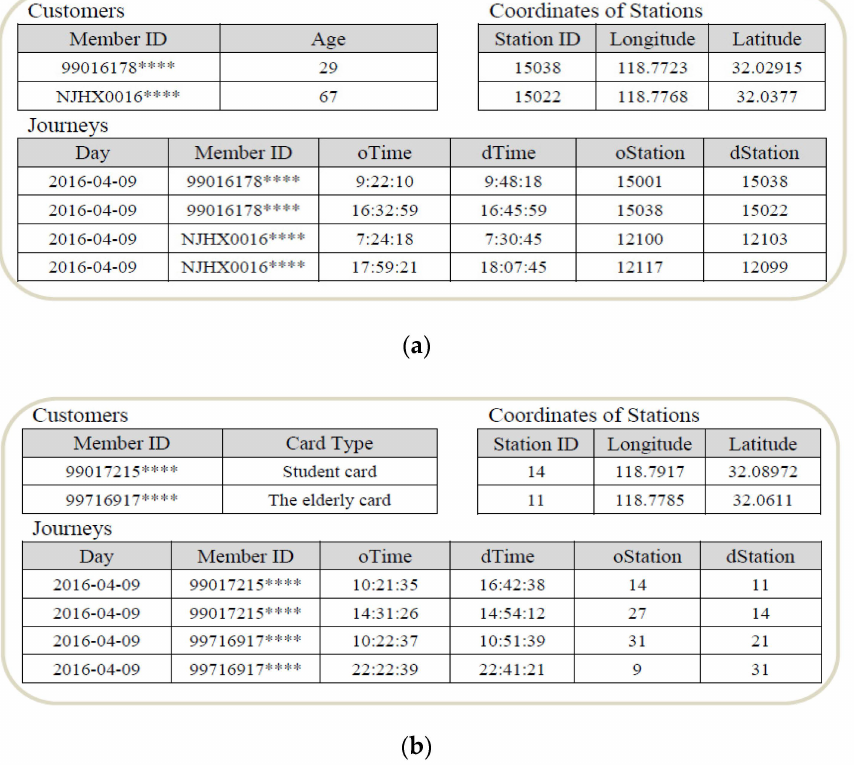
Figure 1. Structure of the datasets of Nanjing Metro and Bikeshare (Note: “Member ID” of dedicated bikeshare cards begins with letters “NJ”, whereas the ID of seamless smartcards begins with number “9”). ( a ) Structure of the datasets of Nanjing Bikeshare, ( b ) Structure of the datasets of Nanjing Metro. Note: User ID are not fully presented to ensure privacy of smartcard